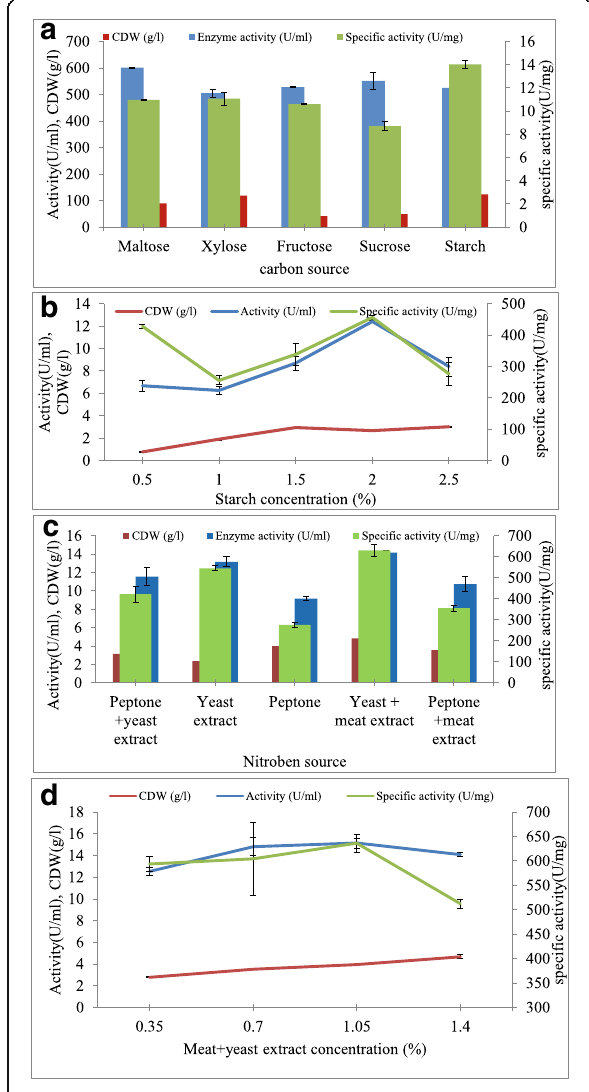
Fig. 5 Effect of different carbon sources ( a ), different concentrations of starch ( b ), different nitrogen sources ( c ), and different concentrations of yeast extract plus meat extract ( d ) on α -amylase production by Bacillus sp. NRC22017. Data were expressed as mean±standard